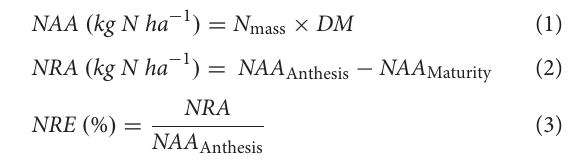
Frontiers in Plant Science |